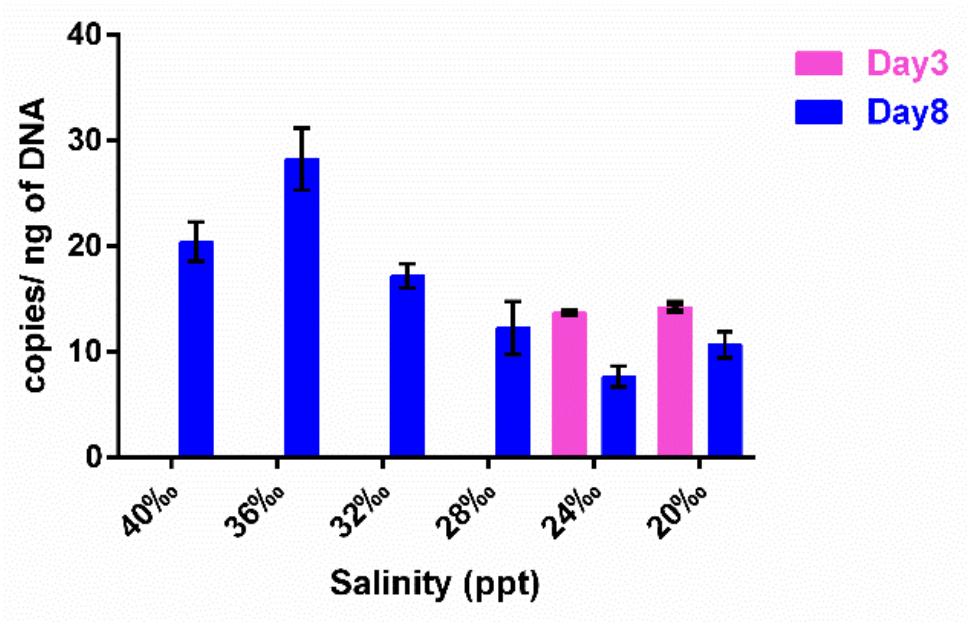
Figure 4. Cl-1 qPCR amplification on SA gDNA extracted from T. rotula xenic cultures grown at different salinities. The cultures were sampled at exponential–early stationary phase (Day 3) and at late stationary phase (Day 8) during their growth.